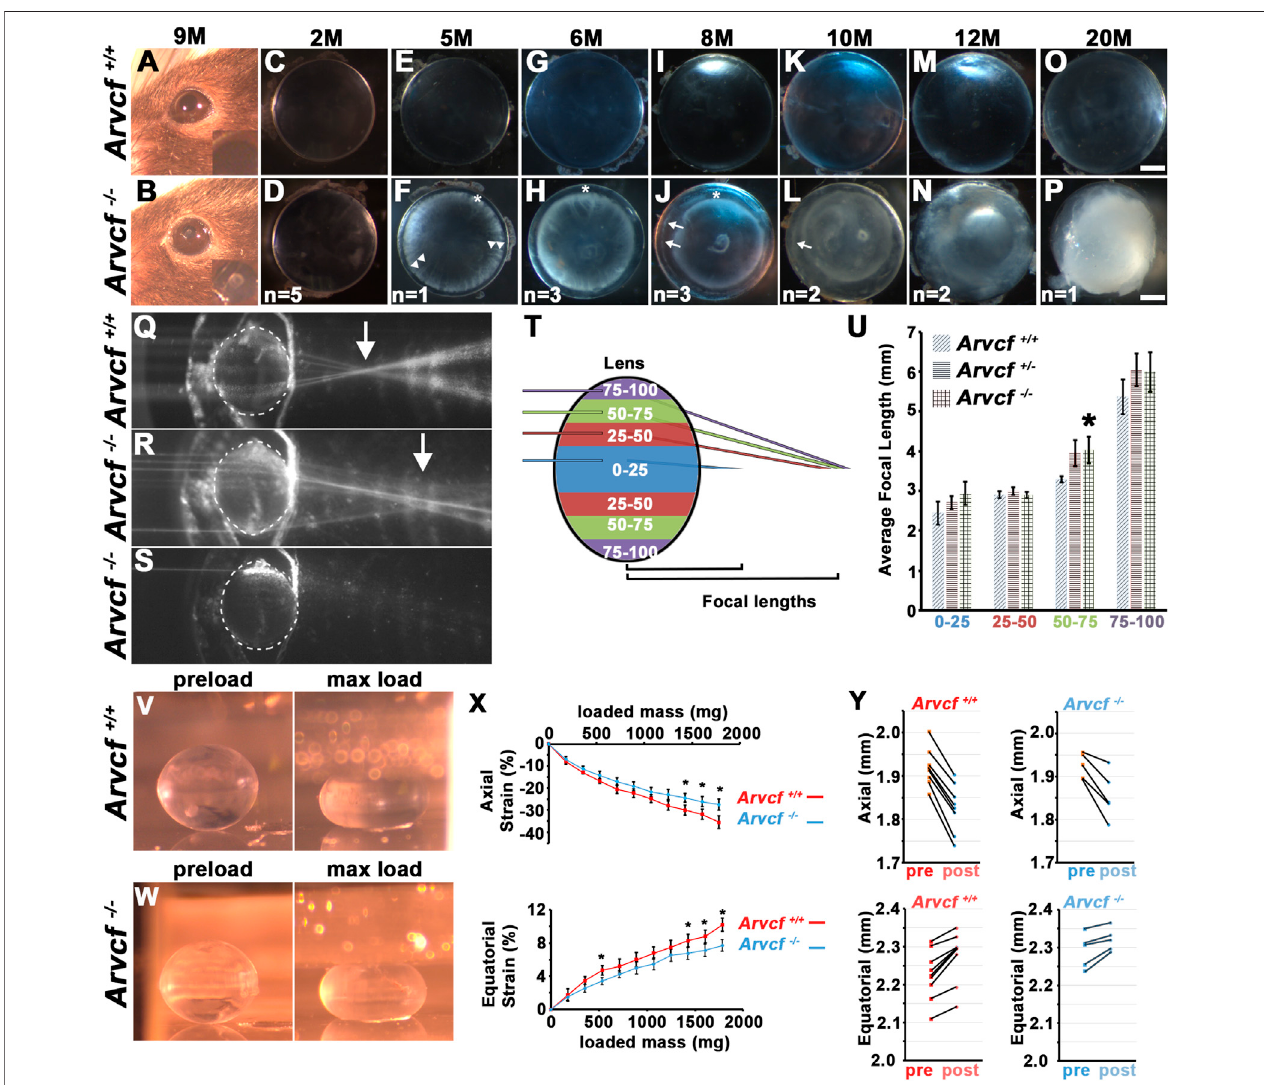
FIGURE 2 | Arvcf is required to maintain lens transparency, refraction, and biomechanical properties. (A – B) Images of the eye of 9 month-old mice with the indicated genotypes. The inset is a magni fi ed region of the pupil. Note the presence of an anterior polar cataract is visible in (B) . (C – P) Representative images of lenses placed on a dark background that were extracted from the eyes of mice with the indicated genotype. The asterisks mark regions of the super fi cial lens that remain transparent, the arrowheads indicate regions of cortical spoking, and the arrows indicate additional regions of cortical opacity within the initially transparent and expandingregion.Thenumberonthebottomofeachimagearethenumberofanimalsexaminedateachage.Notethatwhenopacitieswereobservedtheywerealways bilateral. (Q – S) Compilation of several overlaid images taken of a single representative lens with the paths of several beams of light from a He/Ne laser aimed at several positions along the equatorial axis. Note that the approximate location of several focal lengths are visible and that the arrow denotes that Arvcf mutant lenses have a visibly longer focal length. When aimed at a region of opacity, the beam of light is blocked (S) . (T) Diagram of the laser beam light path positional groups used for quantitation of the focal length measurements. Measurements from each colored region were grouped together. (U) The graph depicts the mean focal lengths and standarderrorforlaserbeampathsthatwerecalculatedfromallofthemeasurementstakenfrommultiplepositions(indicatedbythecoloredregionsin (T) ).Theasterisk indicates a statistically signi fi cant difference from the Arvcf +/+ measurements p < 0.05 ( Arvcf +/+ : n = 11, Arvcf +/- : n = 18, Arvcf − / − n = 6). Scalebar = 500microns. (V) ) Representative stereomicroscope images of 60-day old mouse Arvcf +/+ (top) and Arvcf − / − (bottom) lenses taken through a 45 ° mirror unloaded (left) or loaded with 10 coverslips (right). (X) The graph depicts the mean strain in the axial (E) or equatorial dimension following the addition of 1 – 10 coverslips placed on the anterior pole. The errorbarsrepresentthestandarderrorandtheasterisksdenotedatapointsthataresigni fi cantlydifferentthanthecontrol( p < 0.05).Notethatthe Arvcf − / − lensesdonot deform as readily as the control in both dimensions. (Y) Graphs of the axial (top) and equatorial (bottom) dimensions of control (left) and mutant lenses (right) before coverslipswereadded(pre)and2 minfollowingtheirremoval(post).Notethatafterthistimeperiodthelenseshavenotreturnedtotheirpre-loaddimensions.Eachblack line depicts the change between two time points of the same lens from a single experiment.